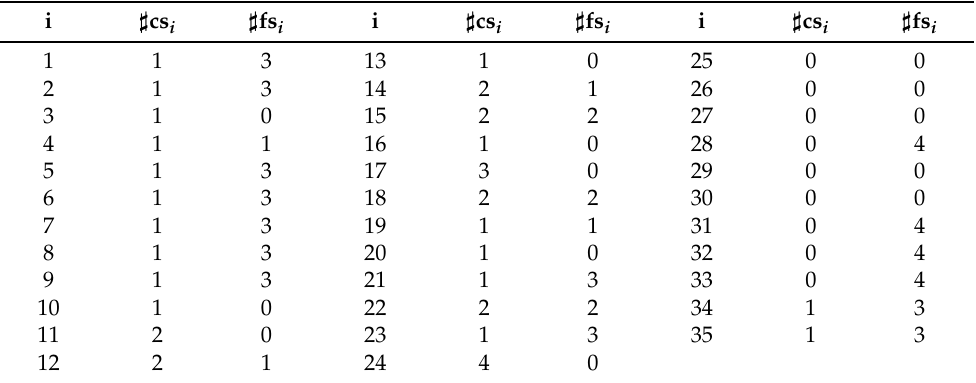
Table 1. Number of constant ( (cid:93) cs i ), fractal ( (cid:93) fs i ) and non-fractal ( (cid:93) nfs i ) 90 × 90 standard image patterns associated to the 35 representatives ( L 4. i ) described in Figure